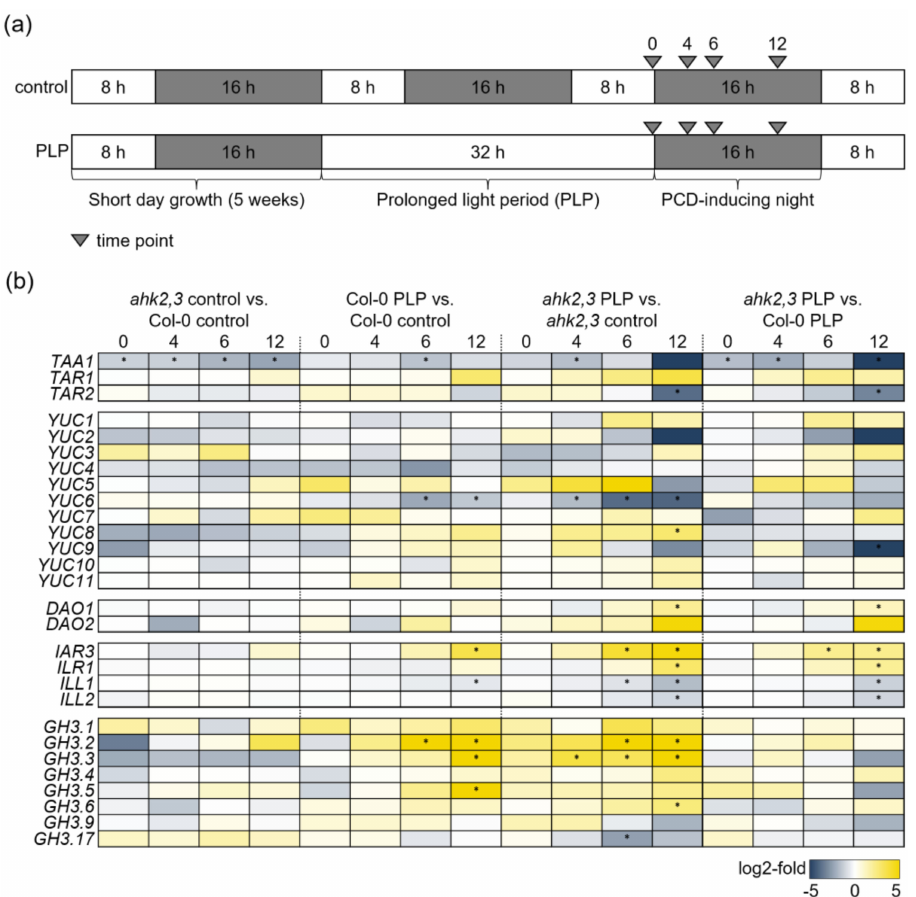
Figure 1. Relative expression of auxin biosynthesis and metabolism genes in response to photoperiod stress in wild type and ahk2,3 . ( a ) Schematic overview of photoperiod stress treatment and sampling time points for gene expression analysis (0, 4, 6 and 12 h after PLP treatment; gray arrows). ( b ) Relative expression levels of auxin biosynthesis and metabolism genes TRYPTOPHAN AMINOTRANSFERASE OF ARABIDOPSIS ( TAA1 ), TAA-RELATED ( TAR ), YUCCA ( YUC ), DIOXYGENASE FOR AUXIN OXIDATION ( DAO ), IAA-ALANINE-RESISTANT 3 ( IAR3 ), IAA-LEUCINE-RESISTANT 1 ( ILR1 ), IAA- LEUCINE-RESISTANT-LIKE ( ILL ) and GRETCHEN HAGEN 3 ( GH3 ) 0, 4, 6 and 12 h after the PLP treatment compared to respective control plants. Stars indicate a significant difference between the indicated genotypes/conditions ( p ≤ 0.05; n = 3; log 2 -fold values are depicted in Supplementary Table S1). Data were extracted from